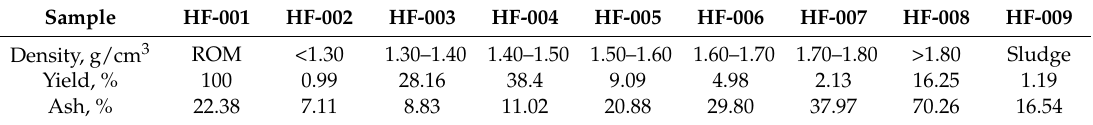
Table 3. Contents of sulfur and trace elements and ash yields in sludge, ROM coal, and various density fractions (in µ g/g unless noted as % or g/cm 3